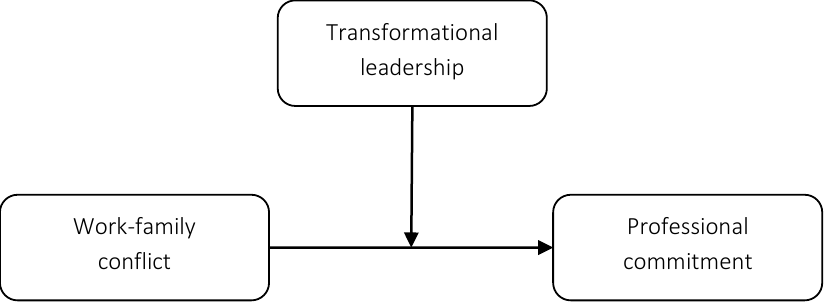
Figure 1. Research